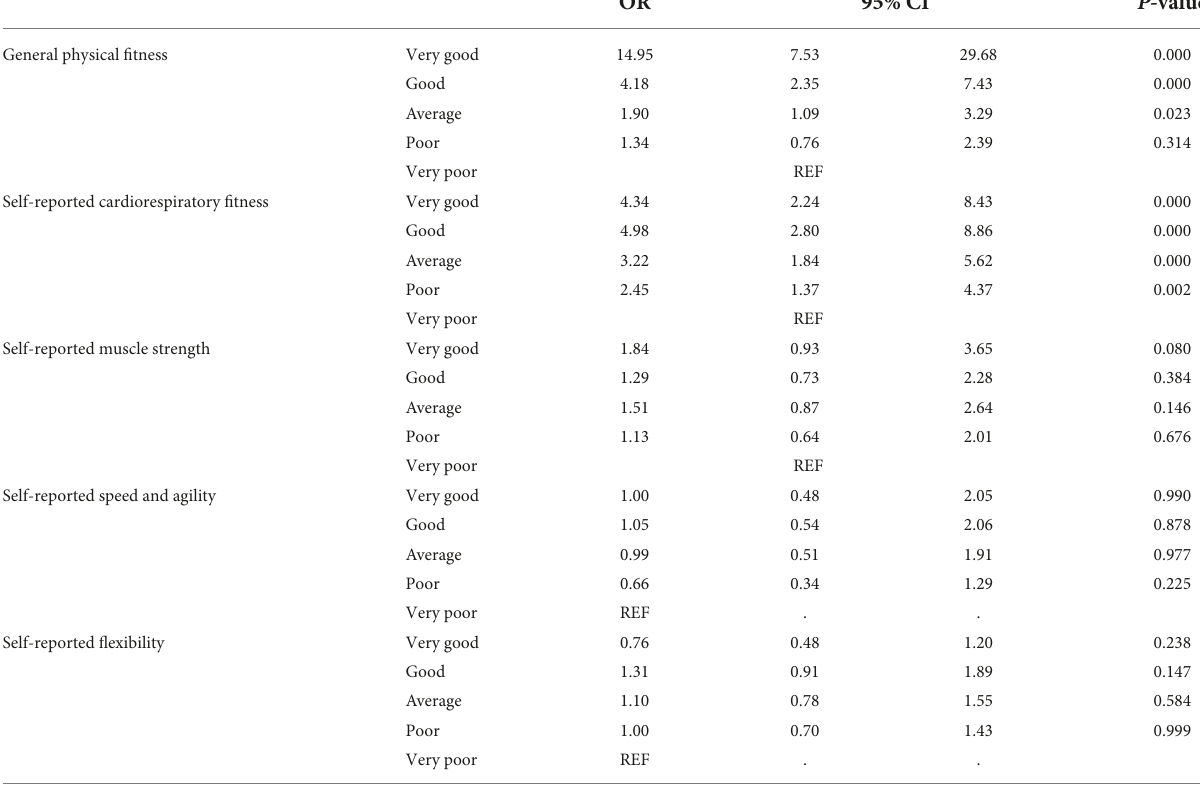
TABLE 4 The association between self-reported physical fitness and self-rated